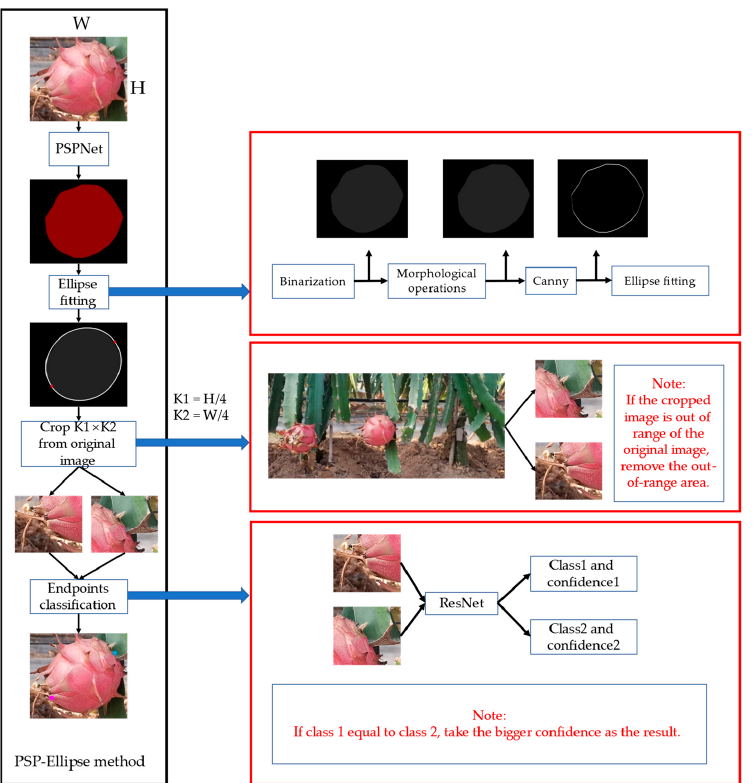
Figure 3. The black box is the fl owchart of the PSP-Ellipse method. The red box is a detailed description of each step. The red font is a note for this operation.